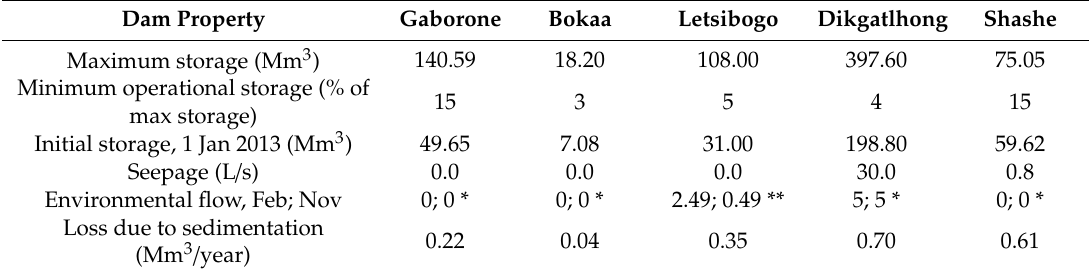
Table 1. Storage properties and environmental flows for the dams included in the Water Supply Security Model